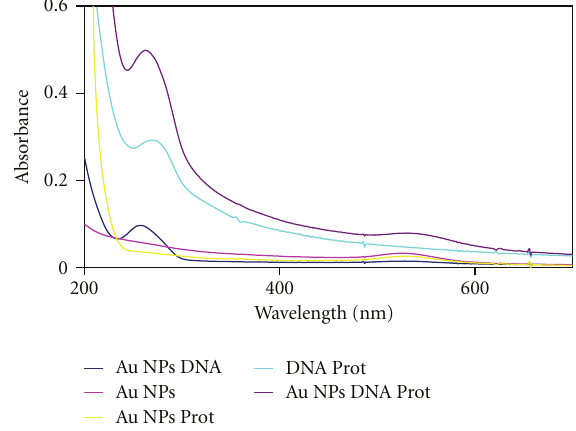
Figure 9: Evidence for bionanoconjugates made between GNPs, protamine, and DNA by